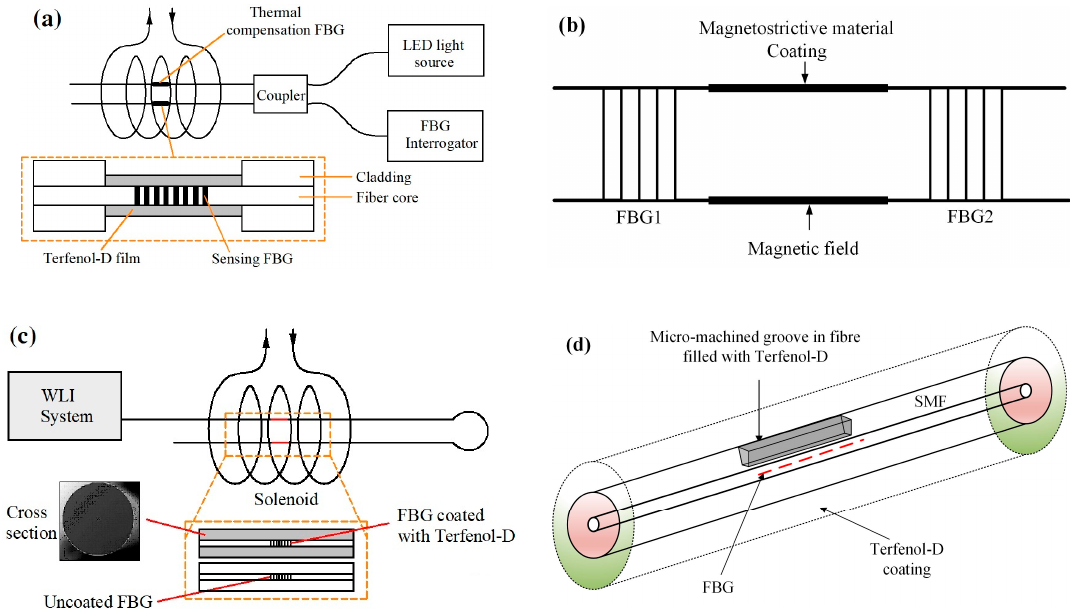
Figure 6. ( a ) Sensing head and system based on etched FBG coated by Terfenol-D film [38], ( b ) sensor probe composed of FBG Fabry–Perot cavity [39], ( c ) Thermal compensated magnetic-field sensor with coated and uncoated FBGs [40], ( d ) sensor head structure of FBG with micro-machined groove filed with Terfenol-D